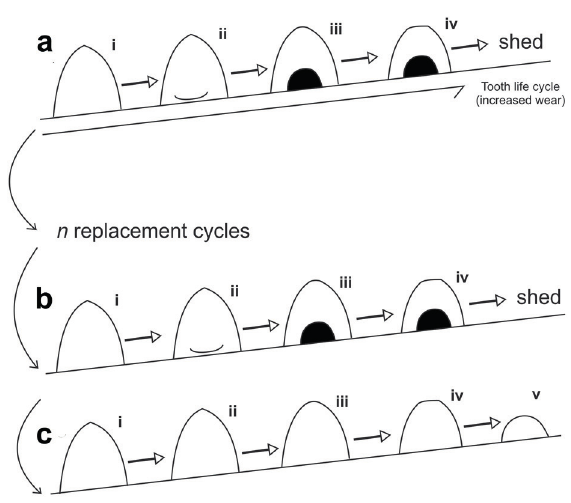
Figure 5 - Schematic drawing of the replacement cycles and the changes in tooth wear and appearance of the resorption pit within each tooth generation (exemplified by a single tooth from each generation). a , juvenile tooth generation; b , penultimate tooth generation; c , last tooth